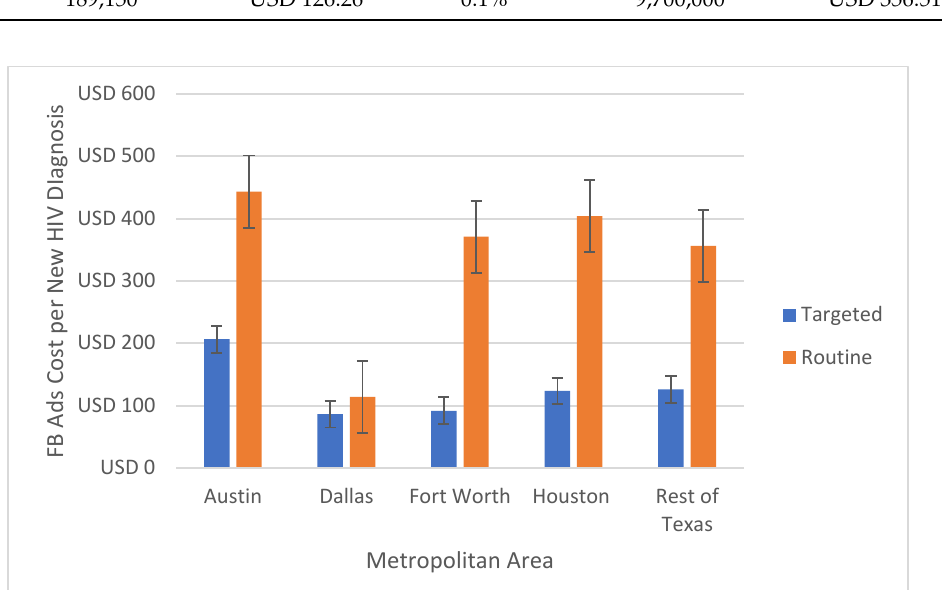
Figure 1. Estimated Ad cost per new HIV diagnosis comparison between targeted and non-targeted models for age groups in Texas, USA.